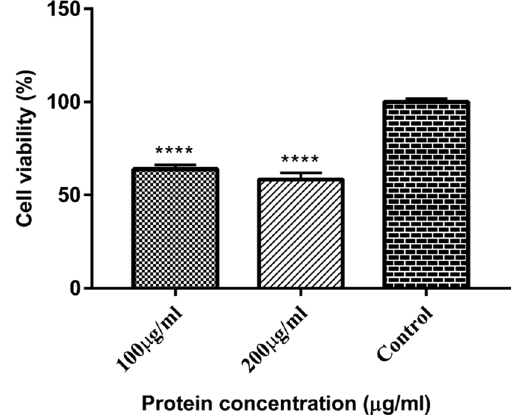
Fig. 5 Percentage viability of HepG2 cells at 100 µg/mL and 200 µg/ mL dose concentrations of purified recombinant IL29